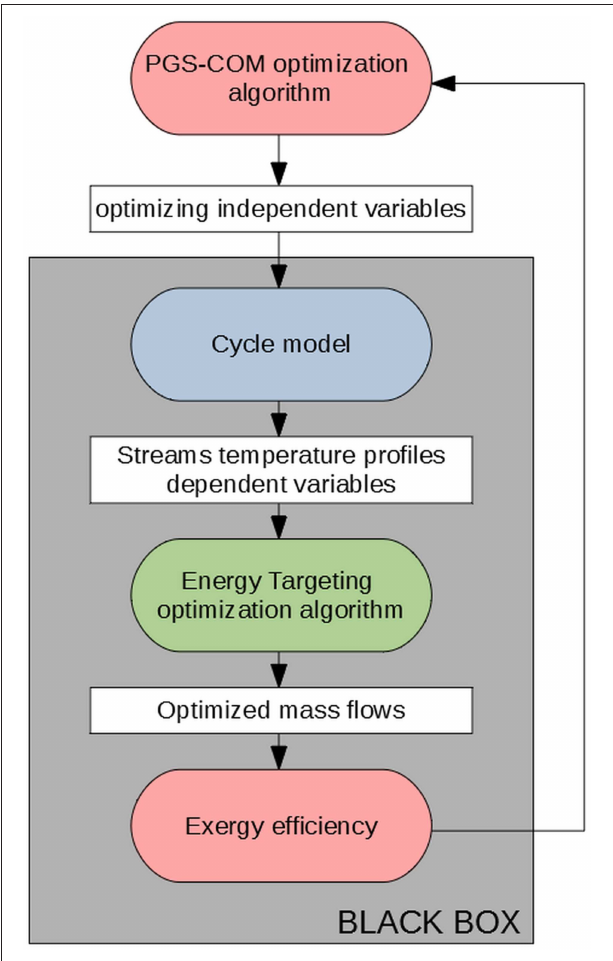
FIGURE 2 | Block-flow diagram of the